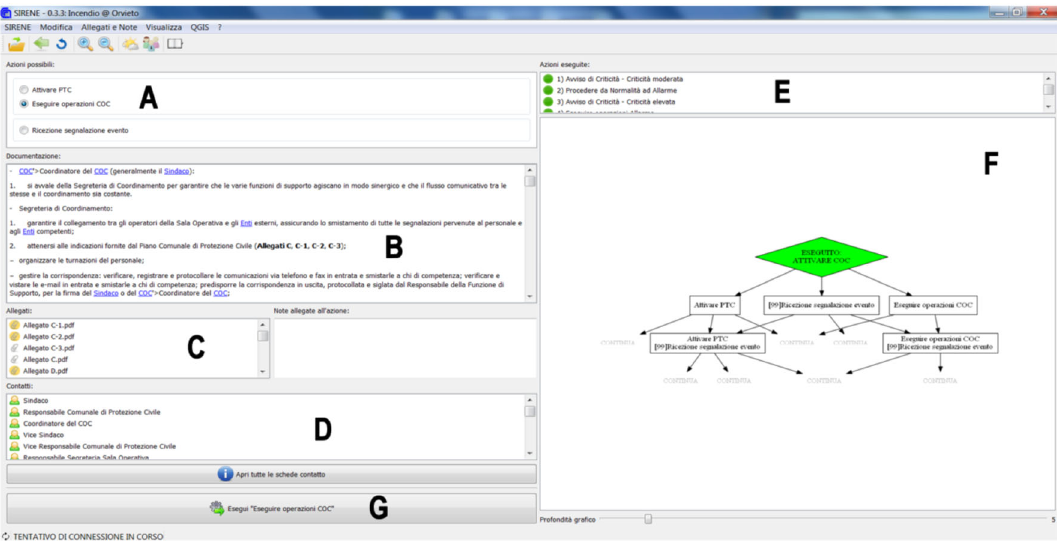
Fig. 5 SIRENE DSS module—an overview of the entire GUI. Capital letters identify each major part of the module. A: the list of selectable actions in a given emergency phase; B: the instructions of execution concerning the chosen action; C: the list of legal documents related to the ongoing action; D: the list of people in charge to give their contribution in executing the chosen action; E: the list of actions